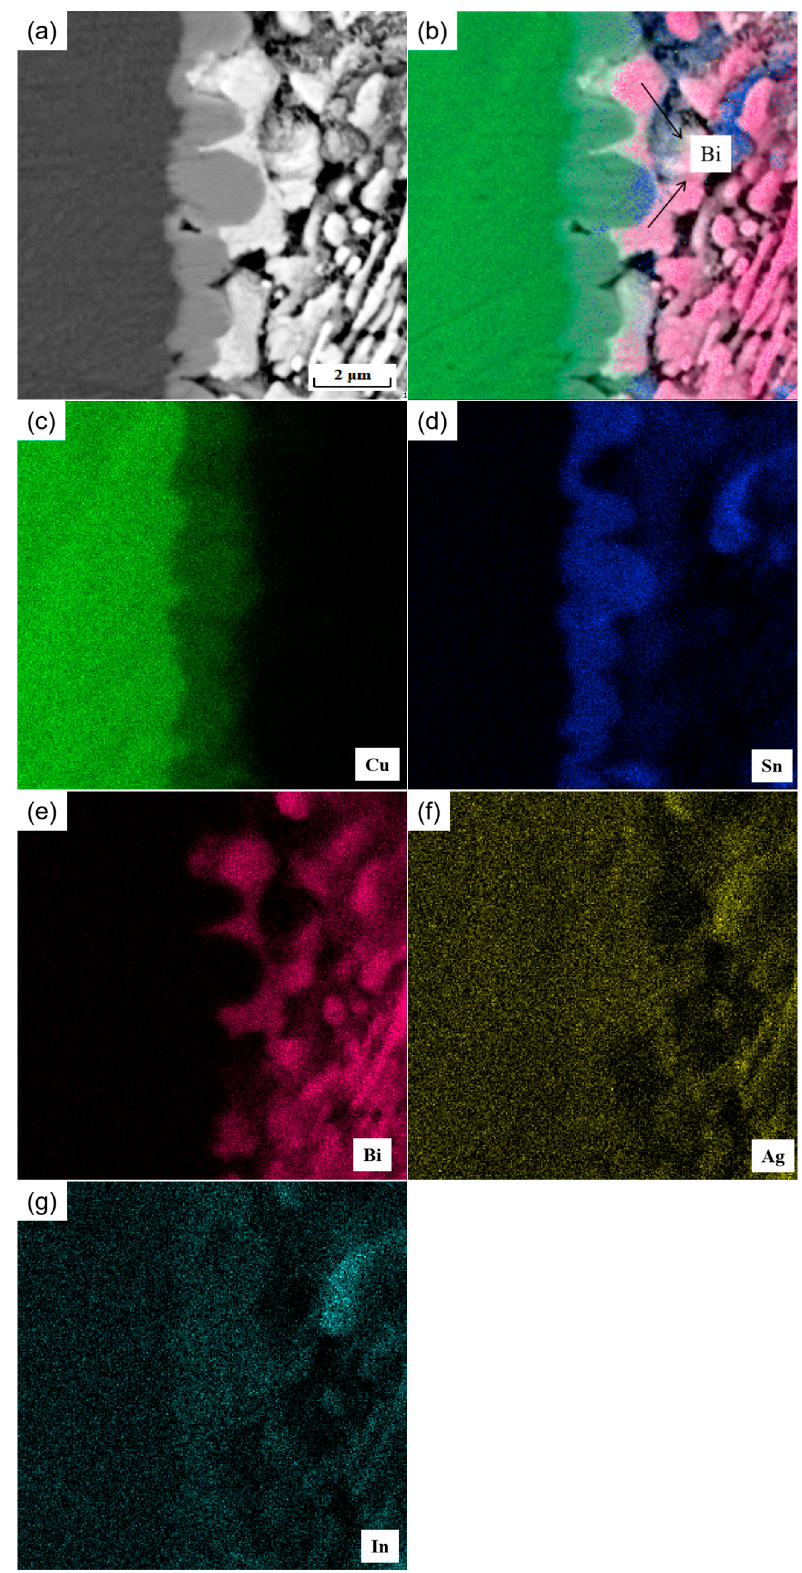
Figure 9. Microstructure and elemental surface sweep of SnBiAg–1.5In/Cu interface: ( a ) SEM image, ( b ) elemental surface distribution, ( c ) Cu, ( d ) Sn, ( e ) Bi, ( f ) Ag, and ( g ) In. The formation of an interfacial IMC layer indicates the chemical bond between the solder and substrate. However, excessive growth of the IMC layer can seriously affect